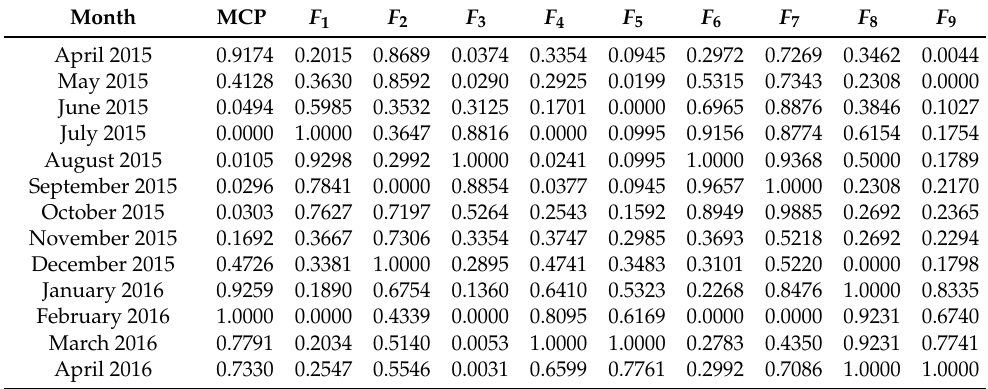
Table 3. Monthly MCP and influence factors of the Yunnan electricity market from April 2015–April 2016.